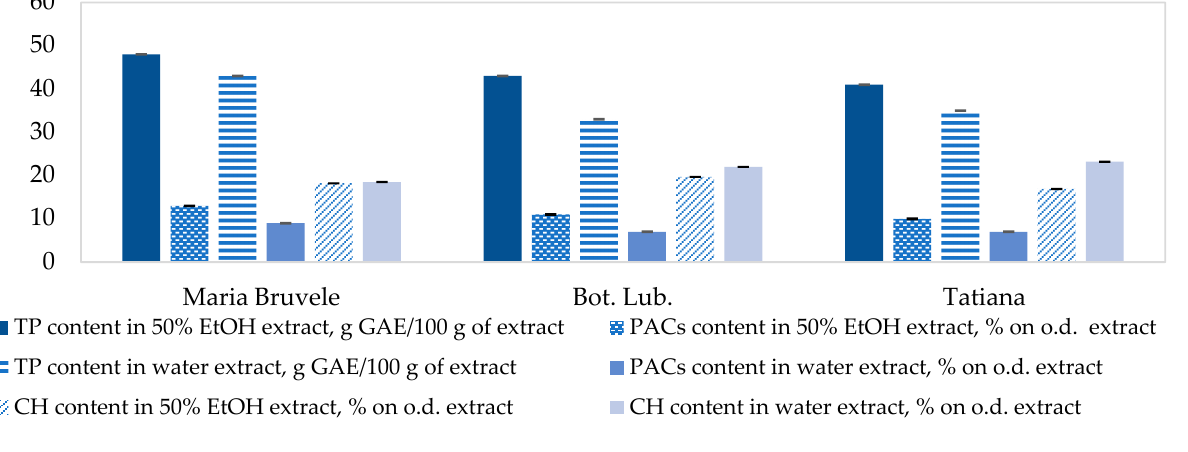
Figure 7. Chemical composition of extracts from SBT biomass. Data represented as mean ± SD ( n = 3).